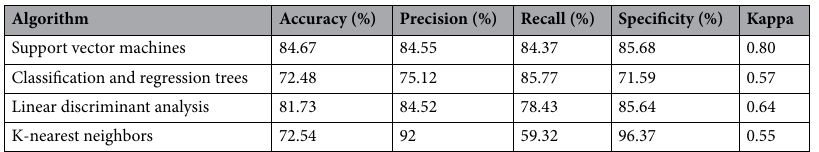
Table 2. Measuring the feasibility of distinct algorithms to classify archaeal promoters. Distinct classification algorithms following a tenfold cross validation of a dataset composed of 3935 promoters and 3935 non- promoters of five distinct archaea were